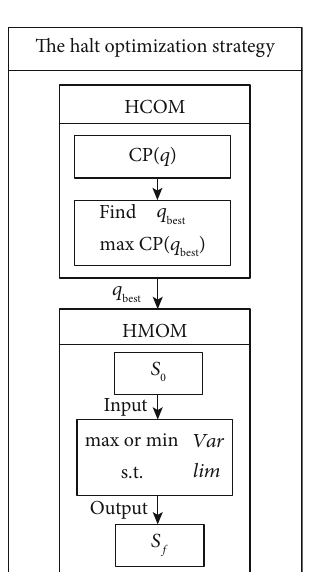
Figure 1: The description of the halt optimization problem.